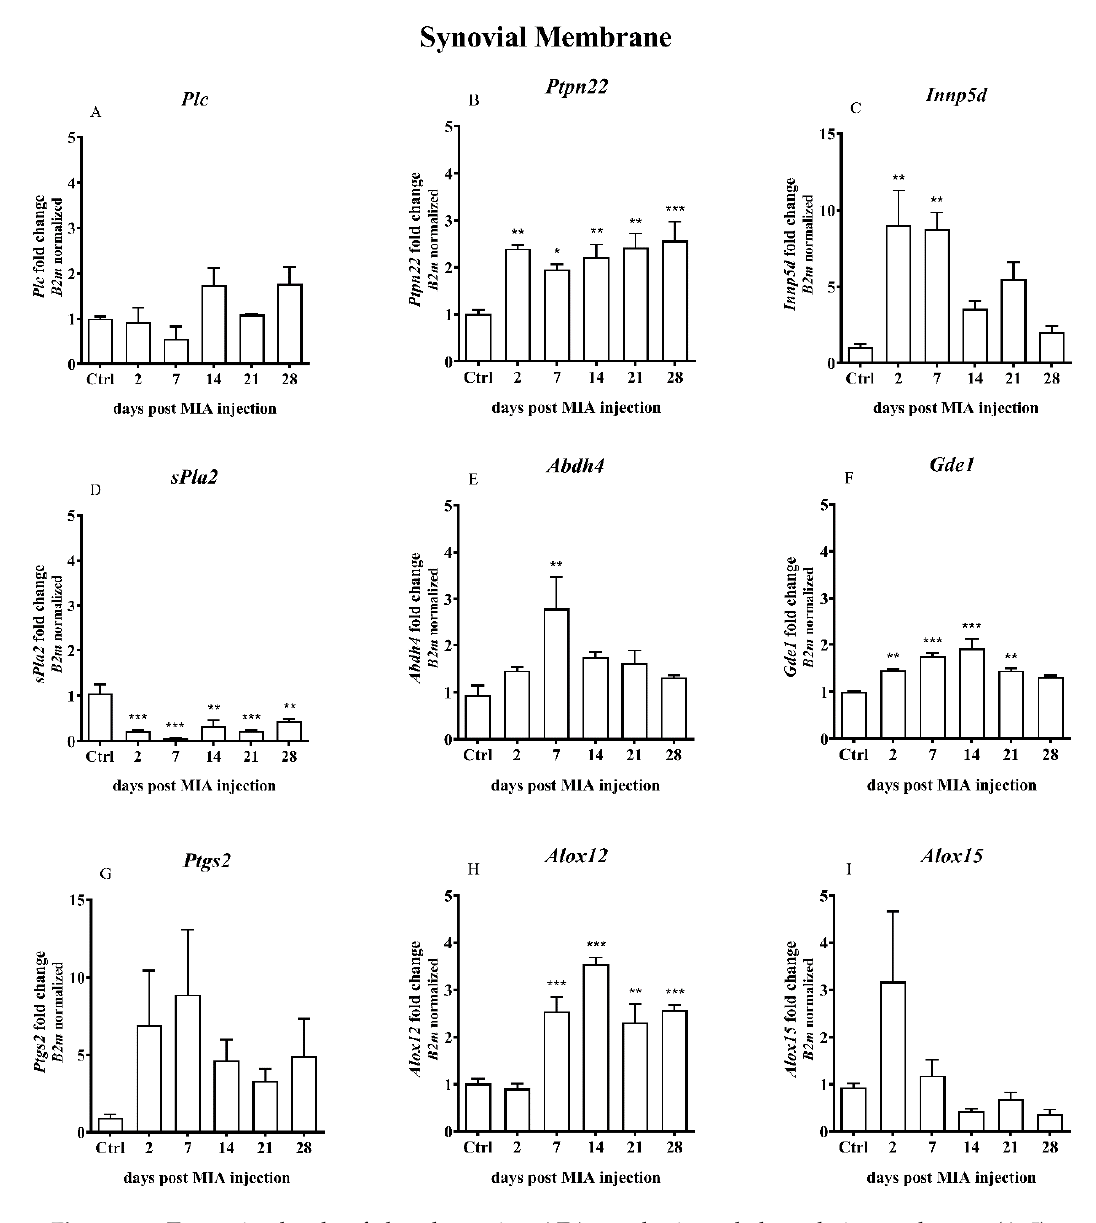
Figure 7. Transcript levels of the alternative AEA synthesis and degradation pathways ( A – I ), including phospholipase C ( Plc ), protein tyrosine phosphatase, non-receptor type 22 ( Ptpn22 ), inositol polyphosphate-5-phosphatase D ( Inpp5d ), phospholipase A2 ( sPla2g2a ), β hydrolase domain containing protein 4 ( Abdh4 ), glycerophosphodiester phosphodiesterase 1 ( Gde1 ), prostaglandin-endoperoxide synthase 2 ( Ptgs2 ), arachidonate 12-lipoxygenase ( Alox12 ) and arachidonate 15-lipoxygenase ( Alox15 ), in the synovial membrane of rats after 3 mg MIA injection during OA development. The samples were collected 2, 7, 14, 21 and 28 days after MIA injection; the control group did not receive any treatment. The groups contained 3–6 samples. Data are presented as the mean ± SEM of fold changes of the group average normalized versus the reference gene ( B2m ). Statistical analysis was performed using one-way ANOVA followed by Dunnett post hoc-test (intact animals treated as a control group). * denotes p < 0.05; ** denotes p < 0.01; *** denotes p < 0.001 vs. intact animals.